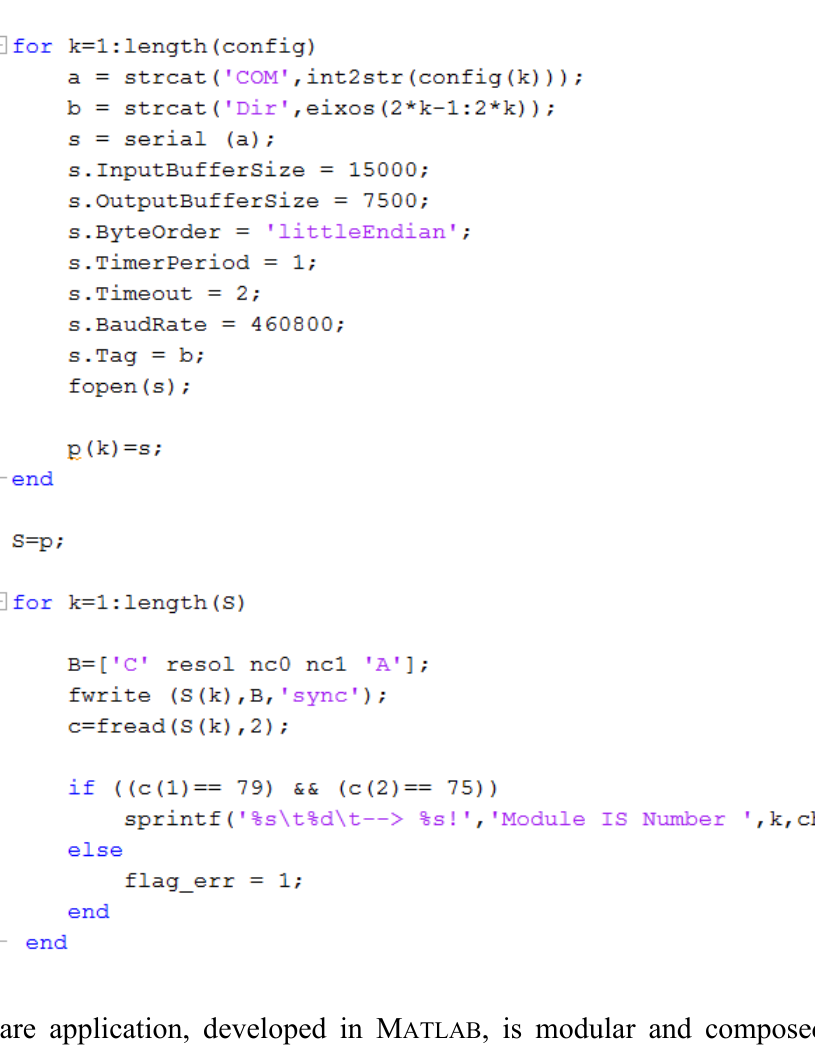
Figure 8. Excerpt of code for the system configuration and IS modules